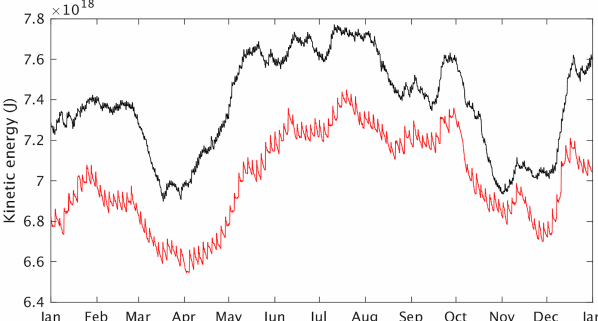
Figure 7. Total kinetic energy (joules) for the 1-day (black) and 3-day systems (red) throughout